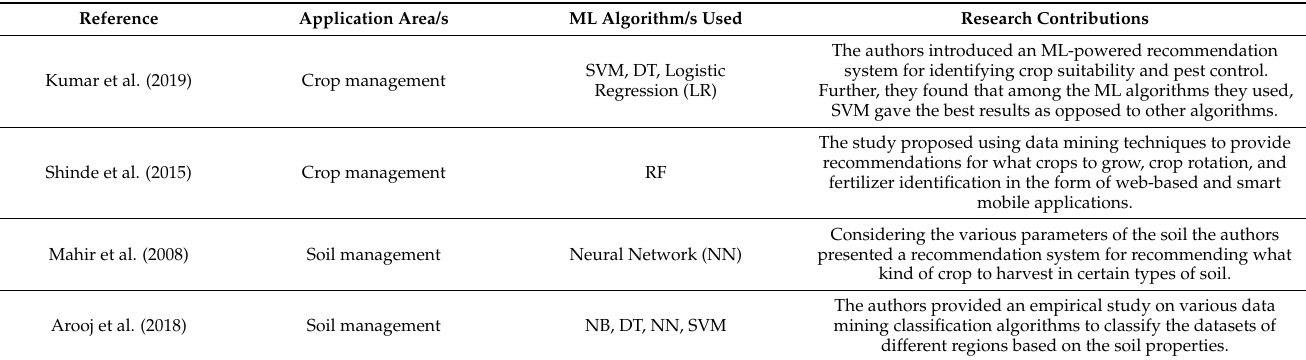
Table 2. Summary of the most recent studies with their